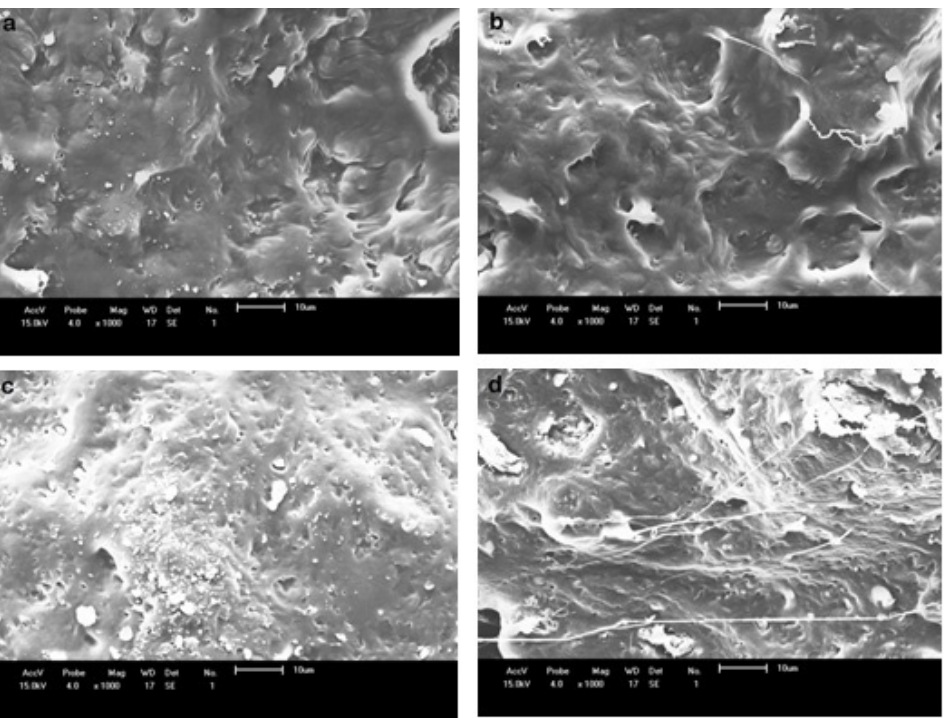
Figure 9. SEM images of PCL non-degraded (a), PCL immersed in water for 45 days of exposure (b), PCL/MMT non-degraded (c), PCL/ MMT immersed in water for 45 days of exposure